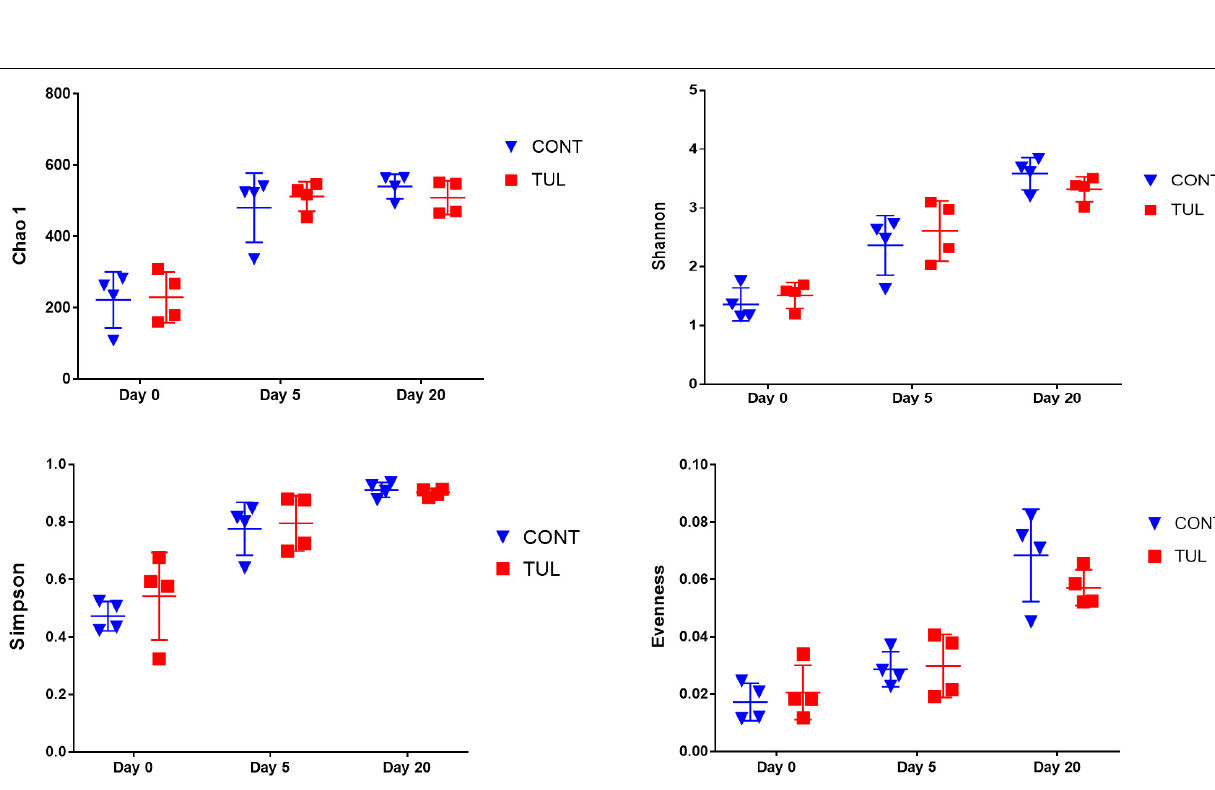
FIGURE 4 | The difference in bacterial diversity indices (Chao 1, Shannon, Simpson and Evenness) measures between the control (CONT) and tulathromycin (TUL) groups at different sampling days (0, 5, and 20). The individual data points, which represent bacterial diversity for each piglet, are depicted. Error bars represent the standard